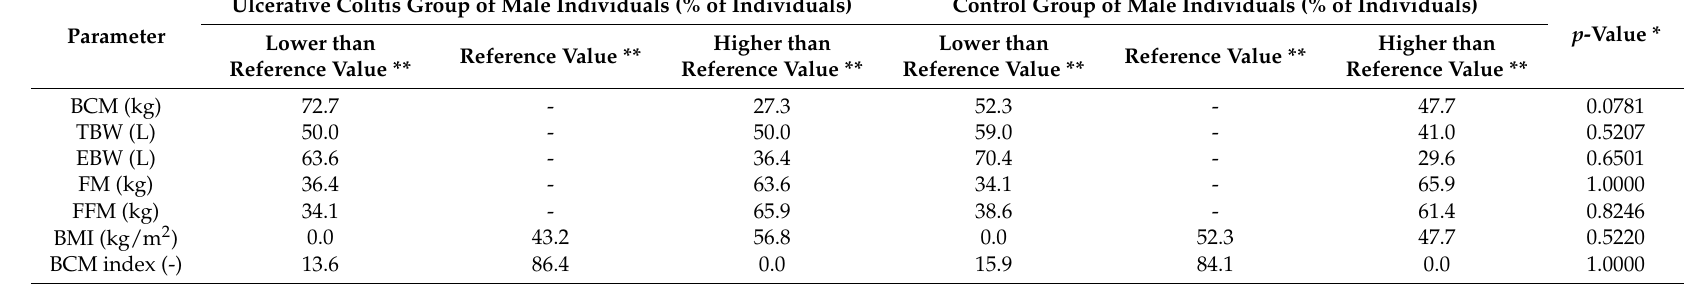
Table 3. BMI and relative results of body composition in comparison with reference values – number of individuals characterized by values in categories, for ulcerative colitis and control groups of male